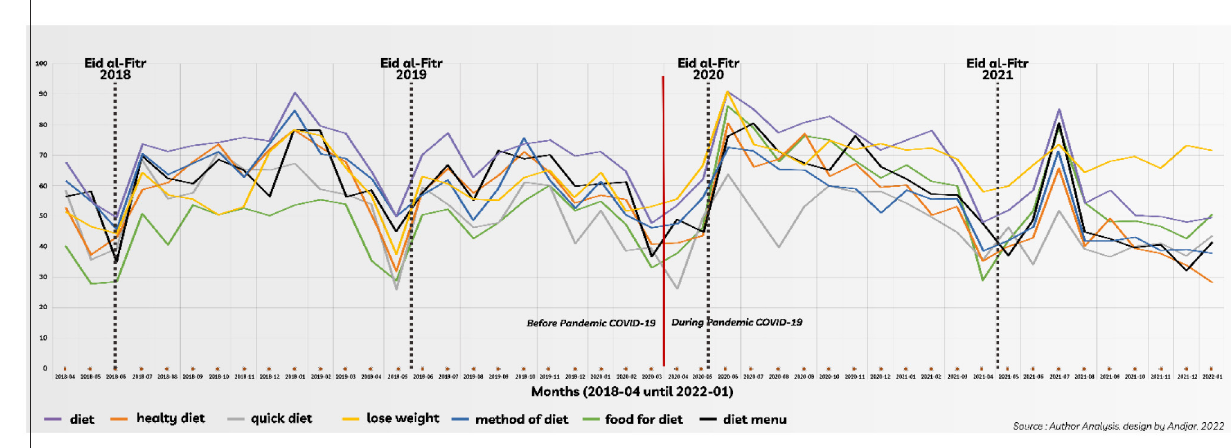
FIGURE1 Timeline according to the topic of diet-related queries and periods (before and during the COVID-19 pandemic).